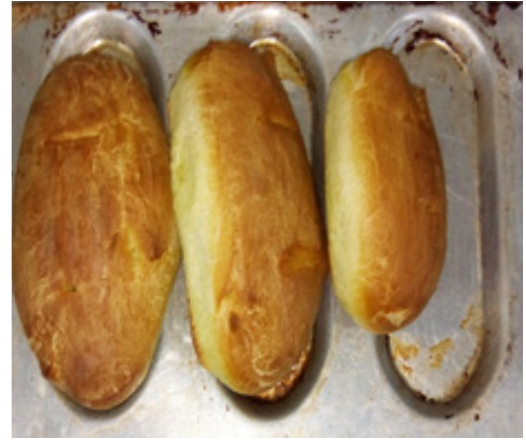
Figure 9: The developed brioche type